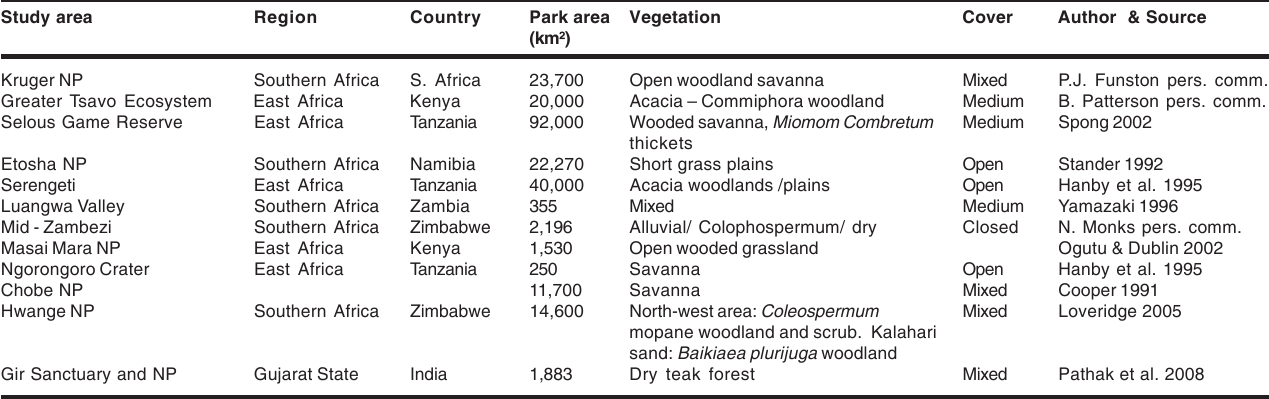
Table 2. Description of location and habitat of lion habitats Study